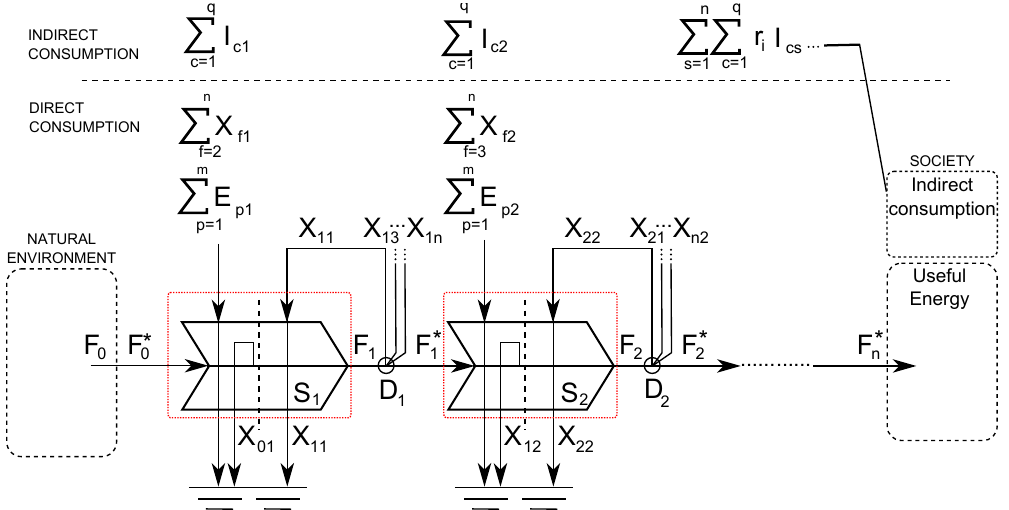
Figure 12. Energy production process with one pathway and n stages, including external ( E ) and indirect ( I ) energy